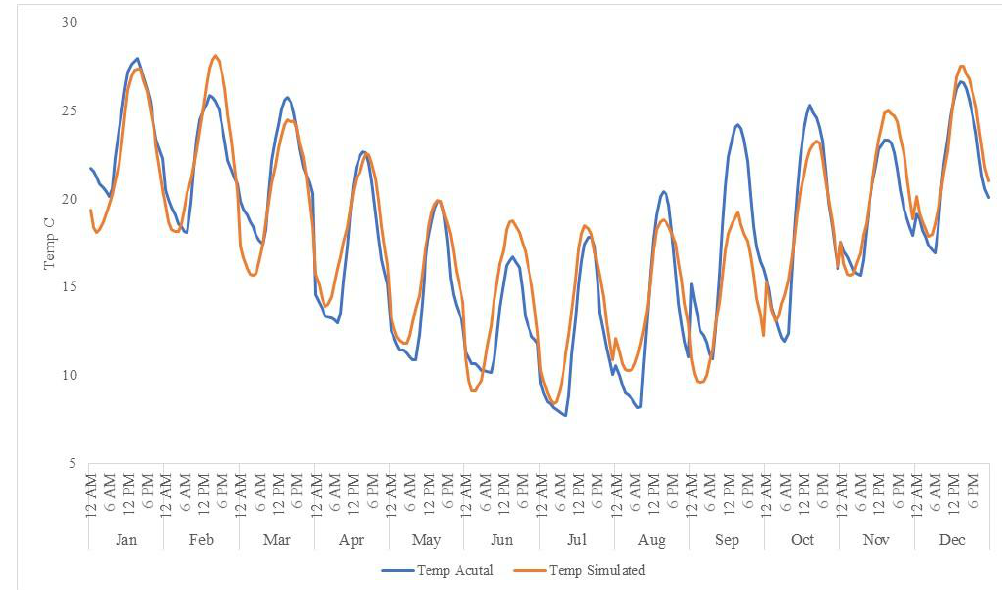
Figure 3. Temperature simulation and historical data daily half hour averages by month. Similarly, TSC simulations were plotted against historical data as shown in Figure 4.